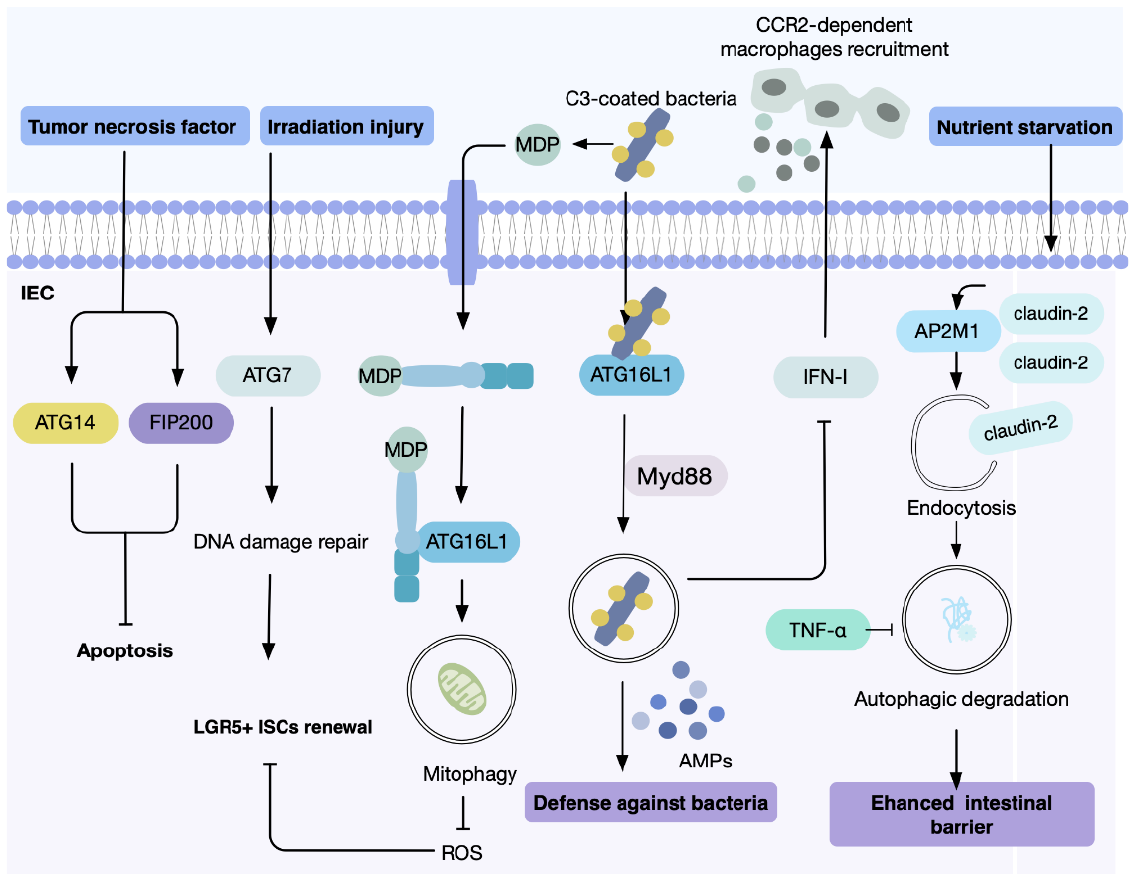
Figure 2. Role of autophagy in intestinal homeostasis maintenance Multiple roles of autophagy in intestinal homeostasis are shown, including regulating the survival of intestinal epithelial cells and intestinal stem cells, the host–microbiota interactions, and the intestinal tight junctions.